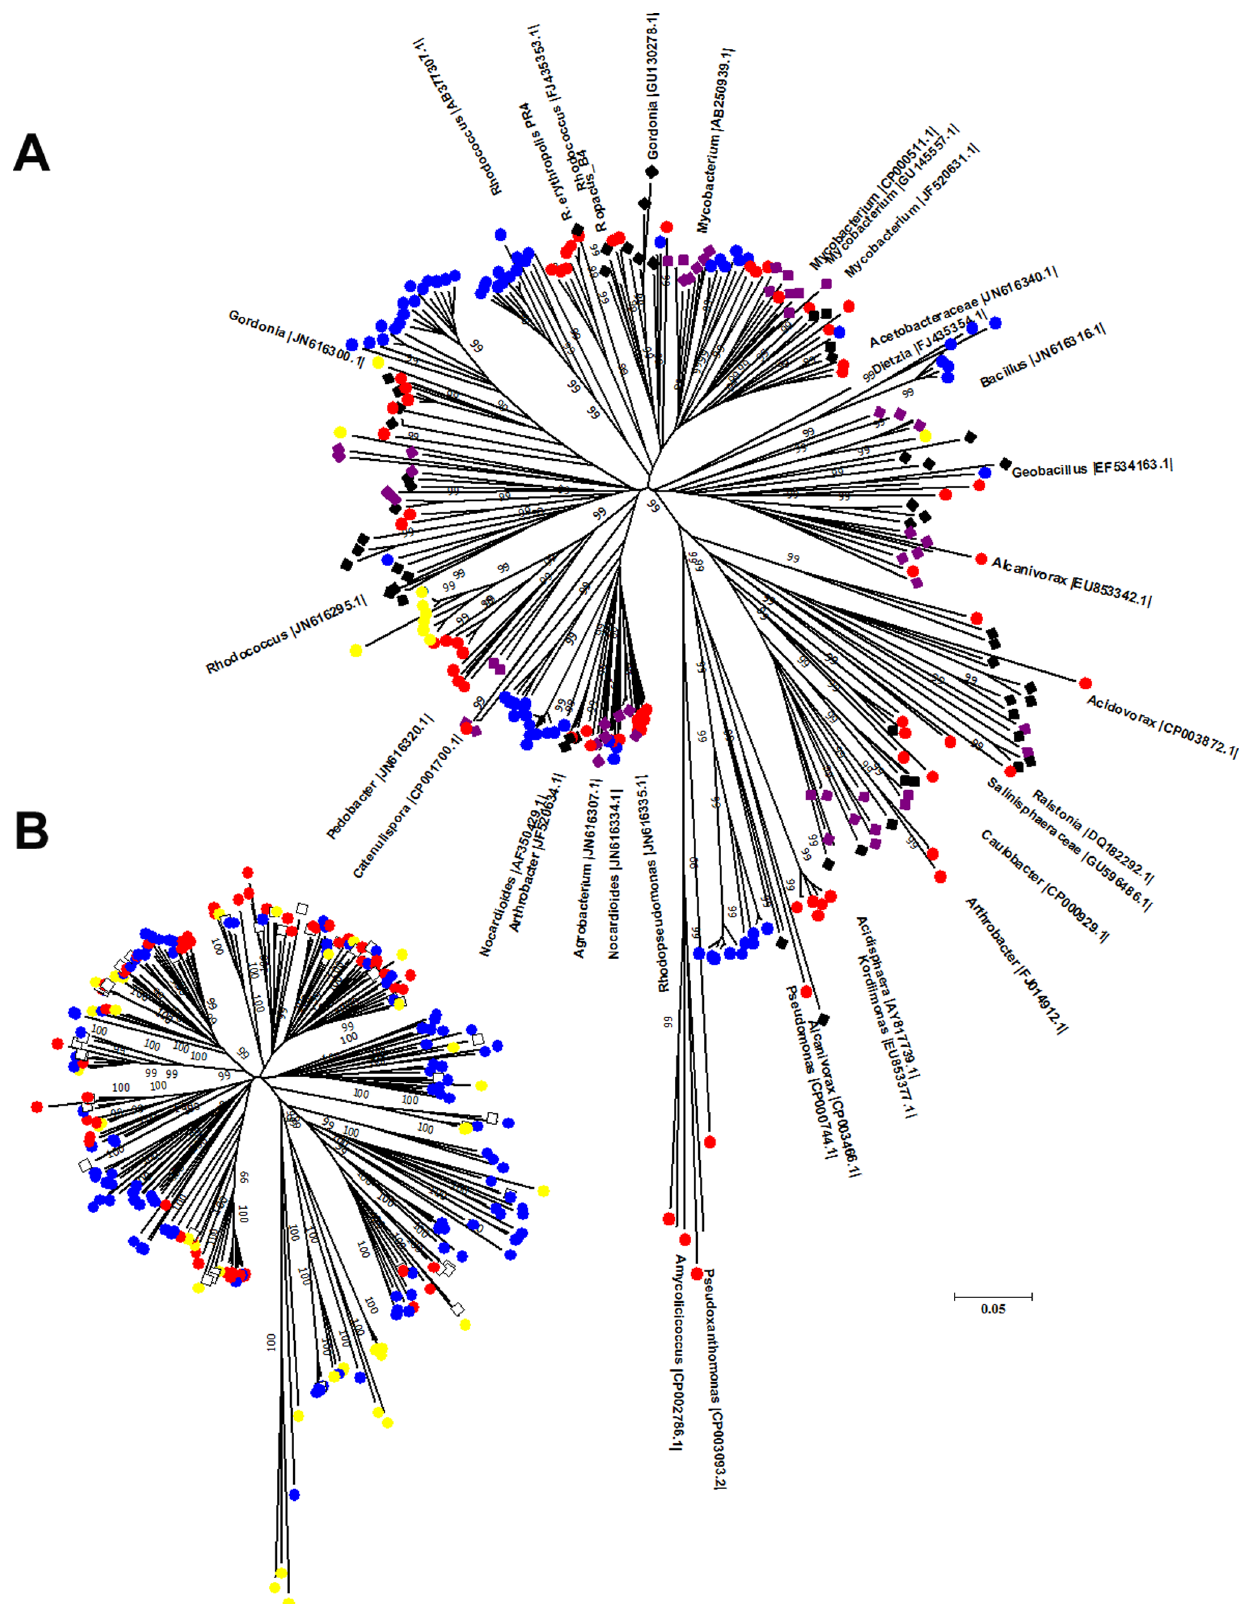
Figure 3. Phylogenetic tree of the alkB sequences obtained from sI, sR, sY, s3 and sC soil libraries and from the closely related alkB genes from the GenBank database (A). The tree was constructed using the neighbor-joining (NJ) method and MEGA 5 software. The